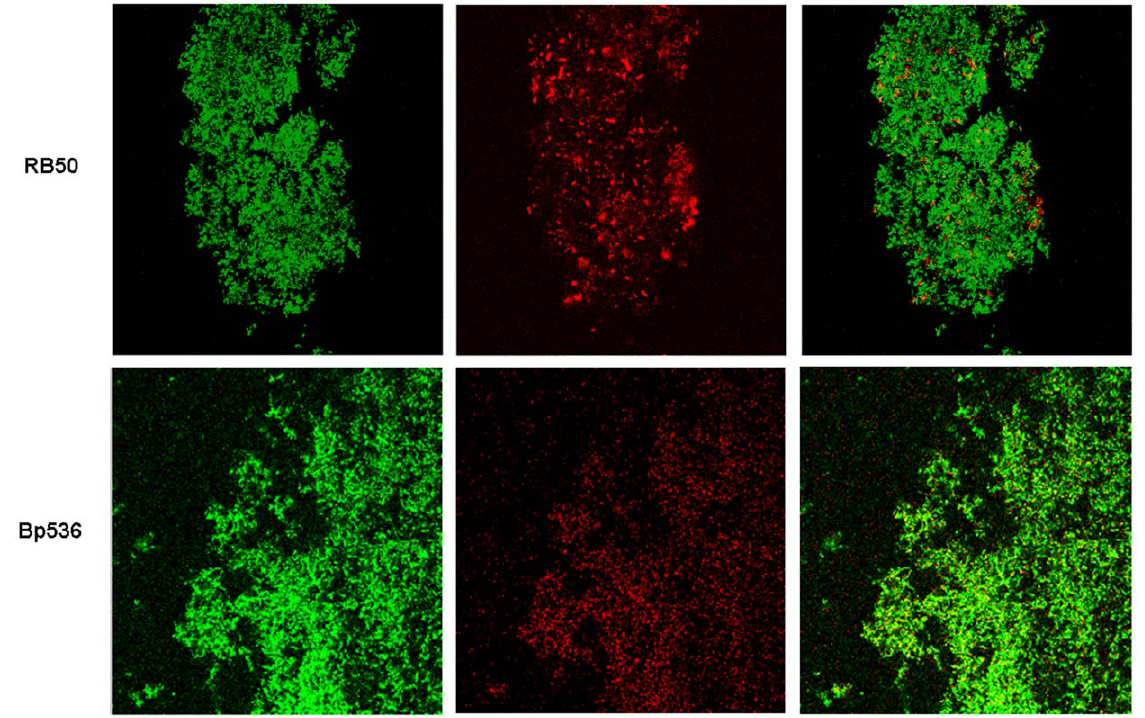
Figure 1. Bordetella biofilms contain eDNA. Three day old biofilms of B. bronchiseptica strain RB50 (upper panels) and B. pertussis strain Bp536 (lower panels) were stained with DDAO. CLSM images of live GFP expressing cells (green) and DDAO stained eDNA (diffuse red) or dead cells (punctuate red) are shown. Yellow appearance indicates the presence of both live cells and eDNA. The images shown are representative of three independent experiments.